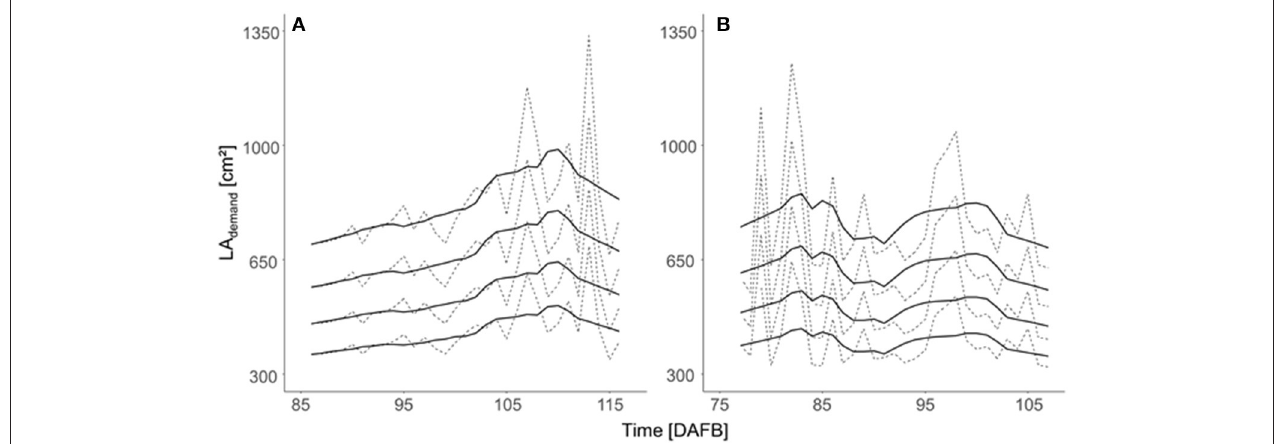
FIGURE 6 | Daily LA demand [LA demand (cm ² )] per fruit estimated for the four target fruit diameters (lines from bottom to top: 65, 70, 75, and 80mm) of ‘Gala’/M.9 trees considering the orchard’s mean total LA of 5.5 m ² during the period 15 d before and after maximum daily fruit C-requirement in (A) 2018 and (B) 2019. Dashed lines represent the estimated daily values and solid lines are the values that are smoothed by using a Savitzky–Golay filter.